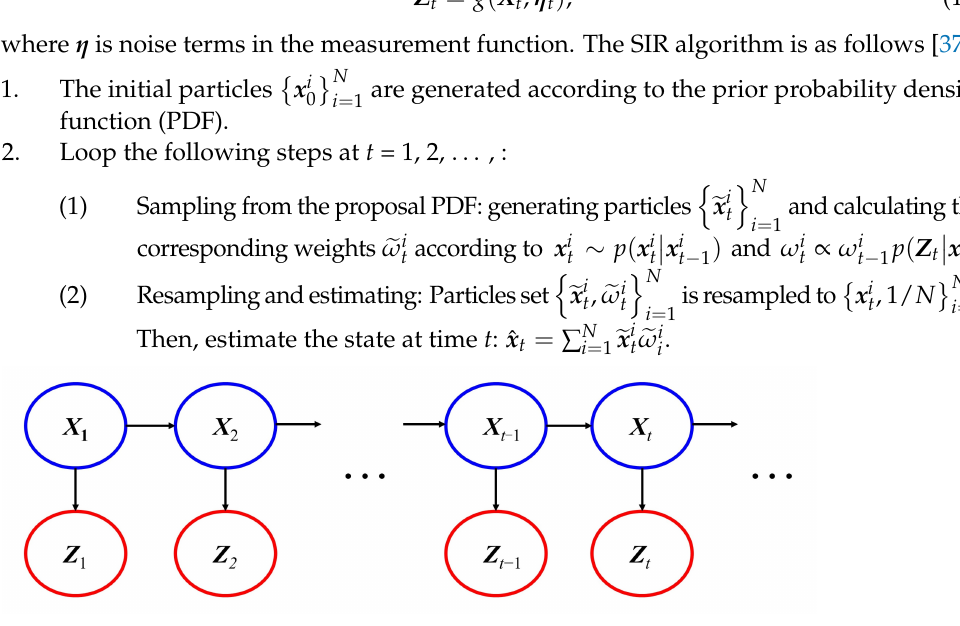
Figure 8. A simple example of a